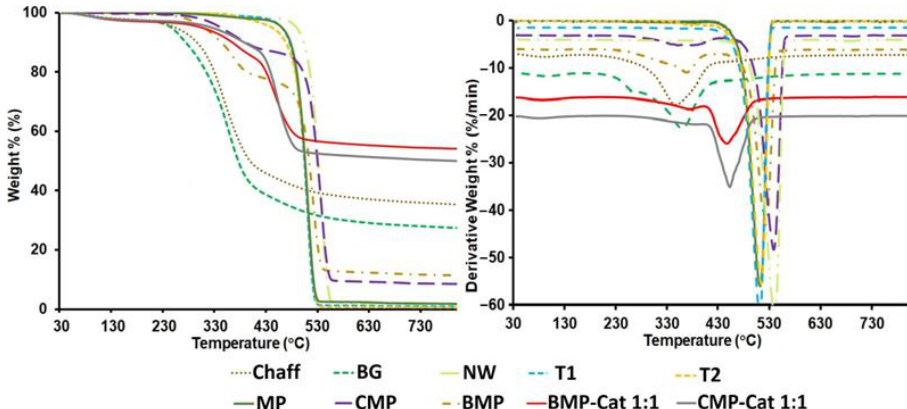
Figure 1. TGA ( left ) and DTG ( right ) thermograms of bluegrass (BG), chaff, net wrap (NW), twine 1 (T1), twine 2 (T2), mixed plastic (MP), bluegrass mixed plastic (BMP), chaff mixed plastic (CMP), BMP-catalyst (1:1), and CMP-catalyst (1:1) at β 20 ◦ C/min heating rates. Table 3. Thermal degradation behavior determined by TGA of bluegrass (BG) straw, chaff, net wrap (NW), twine 1 (T1), twine 2 (T2), mixed plastic (MP), bluegrass mixed plastic (BMP), chaff mixed plastic (CMP), BMP-catalyst (1:1), and CMP-catalyst (1:1) at β 20 ◦ C/min heating